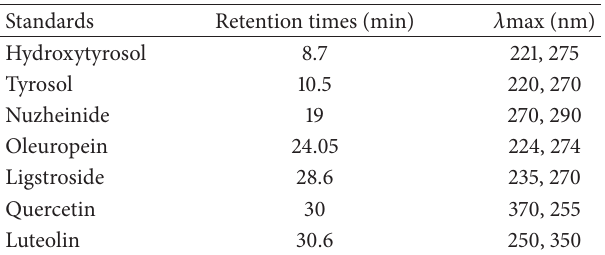
Table 1: Identification of the principal compounds in chetoui O. europaea variety extracts with their retention times and UV